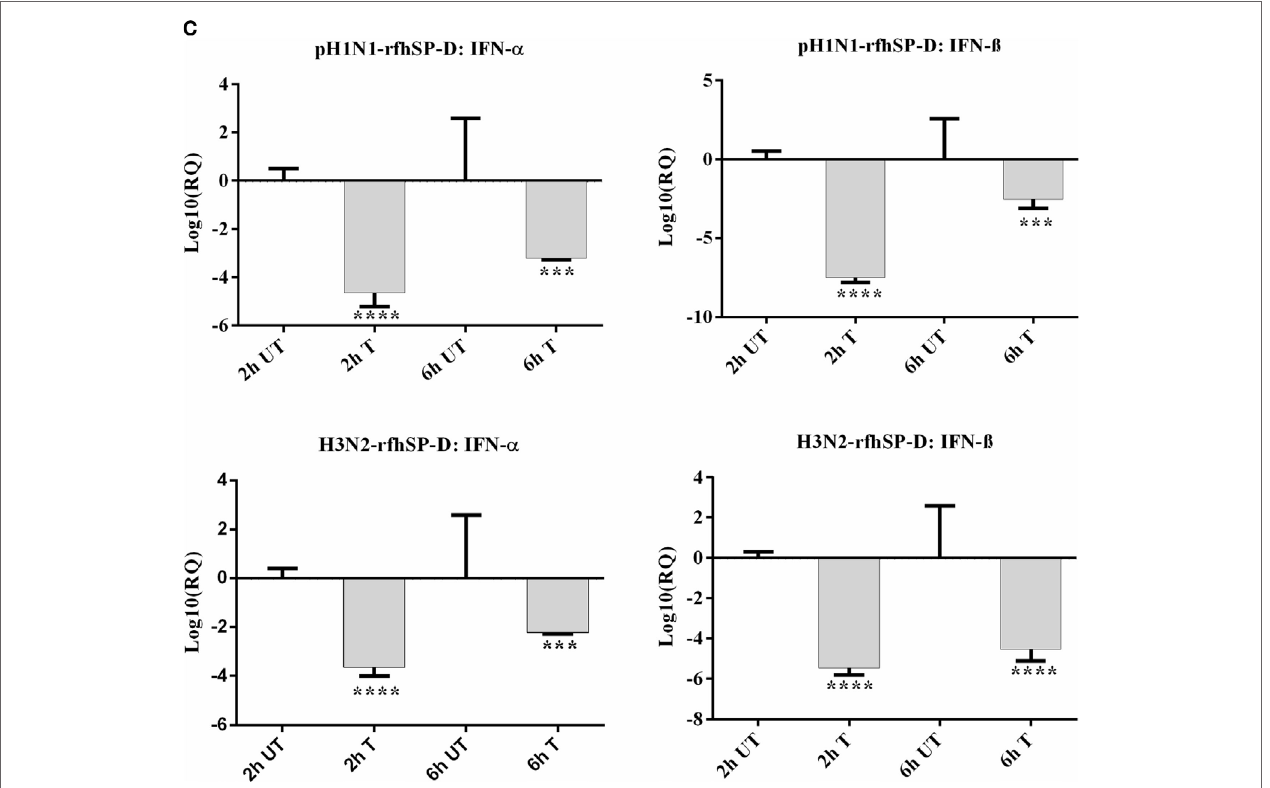
FigUre 6 | Differential mRNA expression profile of A549 cells challenged with pre-incubated (a) pH1N1, (B) H3N2 with rfhSP-D, and (c) expression levels of type I interferon (IFN) subtypes in both untreated and treated samples. The expression levels of cytokines and chemokine were measured using qRT-PCR and the data were normalized via 18S rRNA expression as a control. The relative expression (RQ) was calculated by using cells only time point as the calibrator. The RQ value was calculated using the formula: RQ = 2 −ΔΔ Ct . Assays were conducted in triplicates and error bars represents ± SEM. Significance was determined using the unpaired one-way ANOVA test (* p < 0.05, ** p < 0.01, *** p < 0.001, and **** p < 0.0001) ( n =